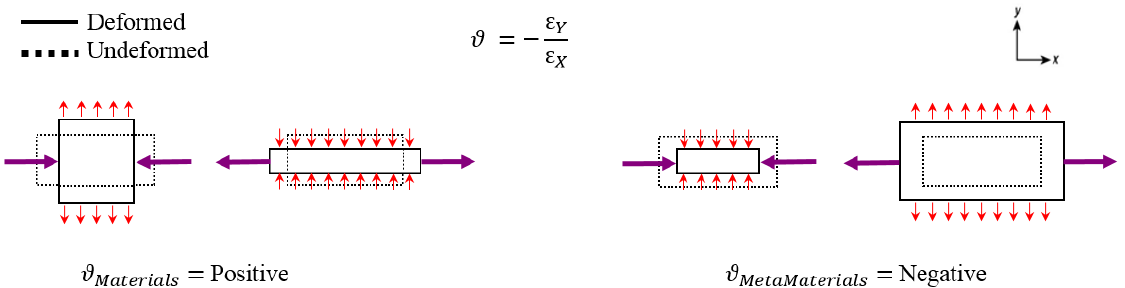
Figure 1. Schematic of deformed and undeformed states of both usual ( left ) and metamaterials ( right ).